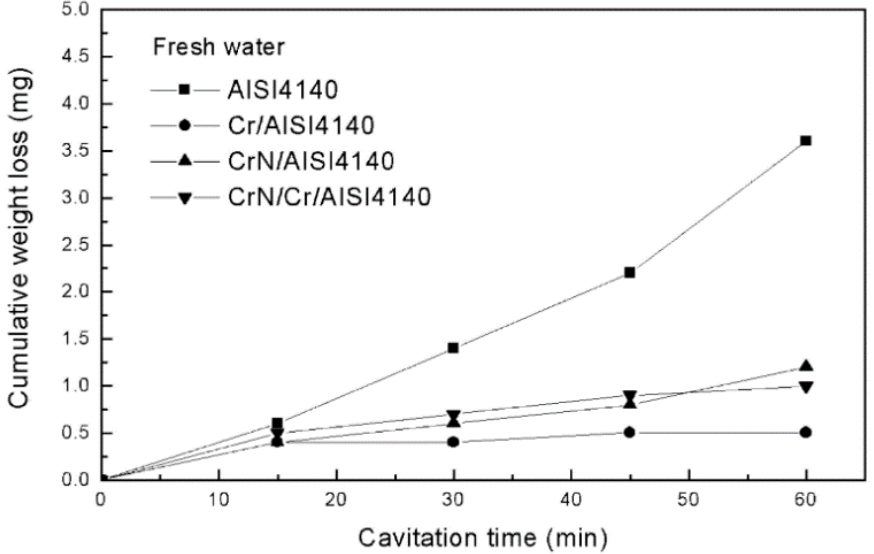
Figure 8. Cavitation curves of 6 µ m thick Cr coating deposited on AISI 4140 steel by commercial electroplating using Atotech HEEF 25 as a catalyst, 1.2 µ m thick CrN and 7.2 µ m thick CrN / Cr coatings deposited on AISI 4140 steel by means of a cathodic arc evaporation PVD method, reprinted from Surface and Coatings Technology , Reference [102], with permission from Elsevier.